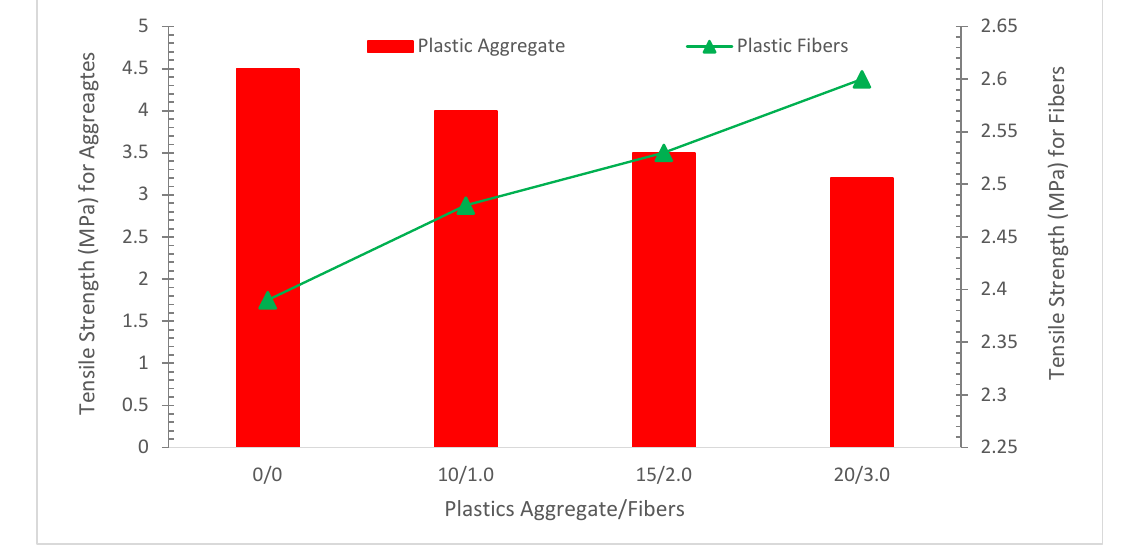
Figure 9. Tensile Strength (STS): Data Source [24,26]. Table 5. Summary of Split Tensile Strength